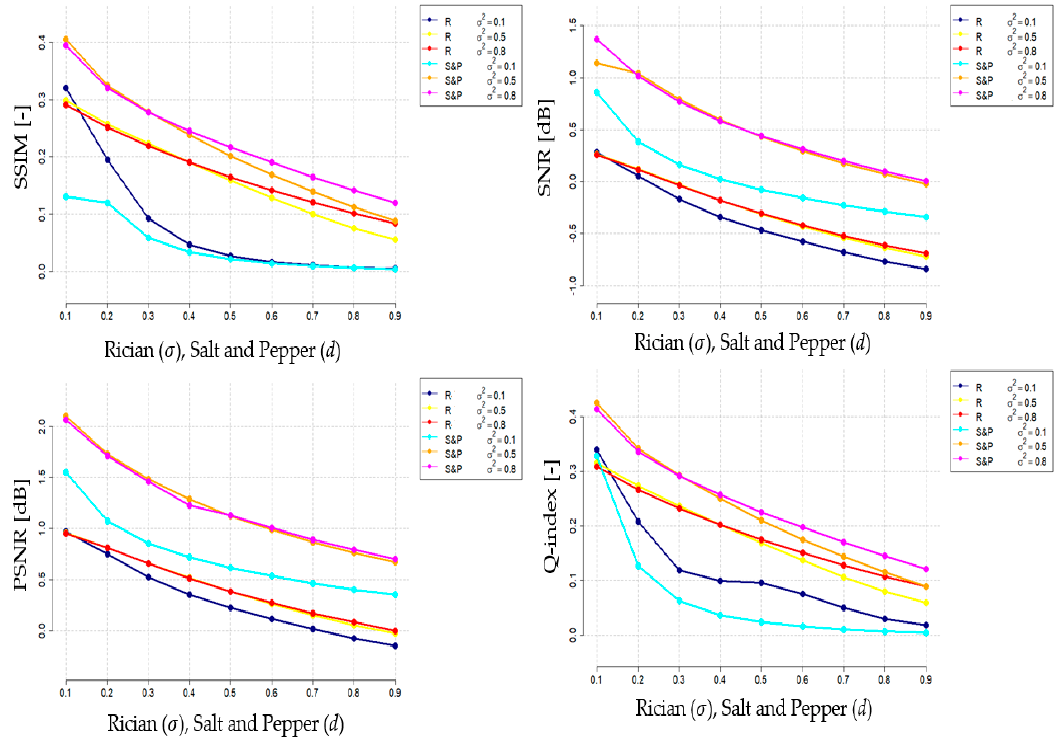
Figure 6. Quantitative characteristics of filter’s performance based on SSIM, SNR, PSNR and Q-index for Rician (R) and Salt and Pepper noise (SaP) with dynamic intensity for optimal filter settings, defined in Table 2 (averaged values).